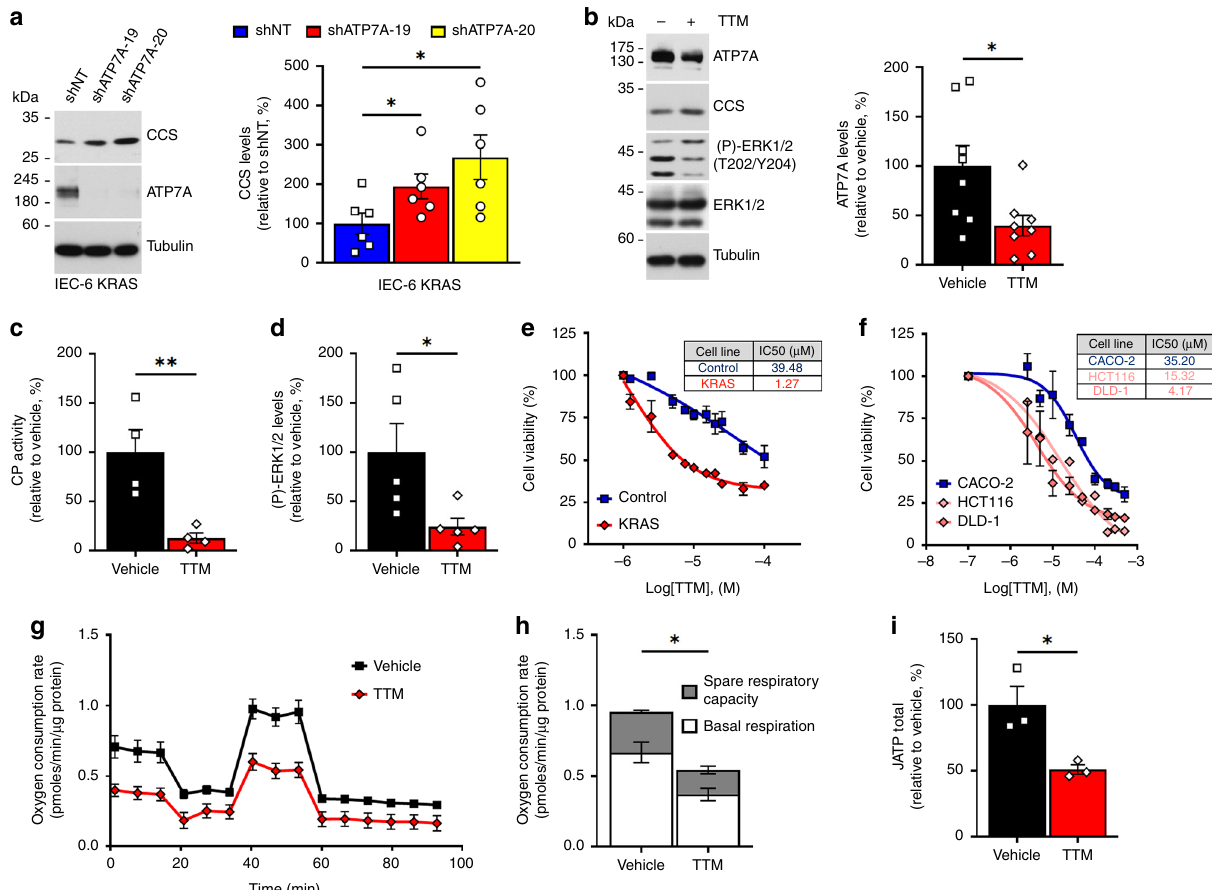
Fig. 4 Cu chelation reduces Cu-dependent functions associated with tumor growth. a IB showing CCS levels upon ATP7A knockdown with NT or ATP7A shRNAs (19 and 20) in KRAS cells, with quanti fi cations (right panel). Data represent n = 6 independent experiments. * P = 0.0460 (shNT versus shATP7A-19); * P = 0.0223 (shNT versus shATP7A-20). b – d KRAS cells were left untreated or treated with TTM for 24 h and b whole-cell lysates were analyzed by IB using antibodies against ATP7A, CCS, total and phosphorylated ERK1/2 and Tubulin. Representative IB images ( b , left), with quanti fi cation of ATP7A levels upon TTM treatment ( b , right). Data represent n = 8 independent experiments. * P = 0.0230. c KRAS cells were analyzed for Ceruloplasmin (CP) activity. Bar chart indicates relative CP activity and data represent n = 4 independent experiments. ** P = 0.0098. d As in b but with quanti fi cation of phosphorylated ERK1/2 levels upon TTM treatment. Data represent n = 5 independent experiments. * P = 0.0380. e Graph depicting the viability of Control and KRAS cells in the presence or absence of TTM at indicated doses. f As in e but for CACO-2, HCT116, and DLD-1. Data are presented as relative percentage (±SEM) of living cells and represent n = 3 independent experiments with three replicates; IC50 values are indicated in adjacent table ( e , f ). g Mitochondrial respiration depicted by Oxygen consumption rate (OCR) was measured in real-time in response to mitochondrial inhibitors oligomycin, FCCP, rotenone and monensin. h Bar charts representing the mitochondrial basal respiration rates (white), * P = 0.0249; the spare respiratory capacity (SRC, gray), * P = 0.0176; and i cellular ATP production rates, * P = 0.0278. g – i Data represent n = 3 independent experiments with six technical replicates. For panels a – d , g – i , center values and error bars represent mean ± SEM, and signi fi cance was determined using unpaired two-tailed Student ’ s t